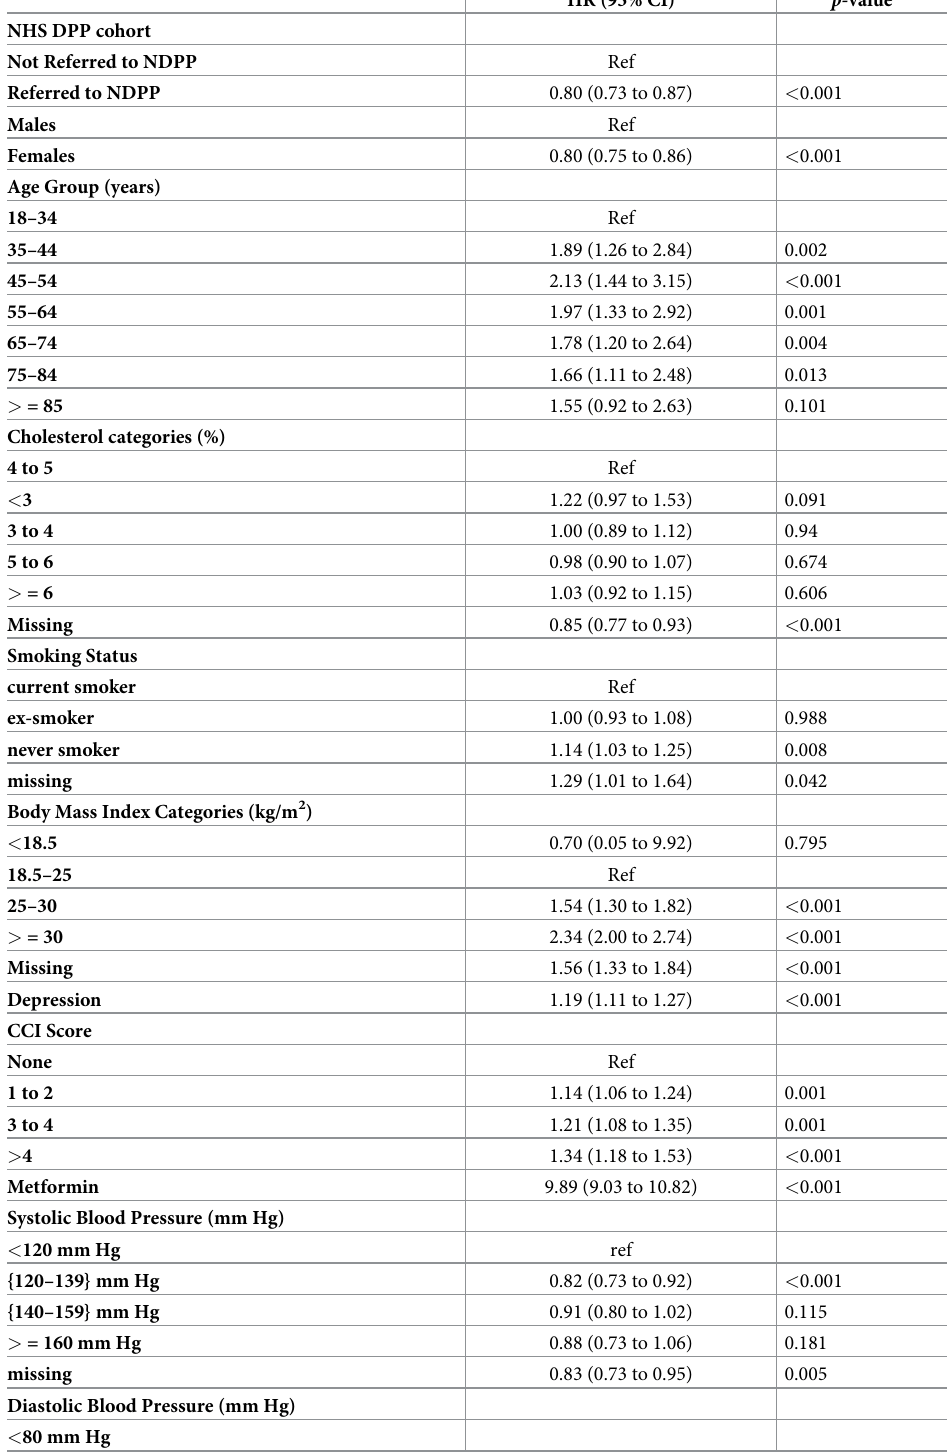
Table 2. Cox proportional hazard models exploring time to conversion of referred to T2DM for patients (cases and controls) by baseline characteristics, with shared frailty for practice. HR (95% CI) p